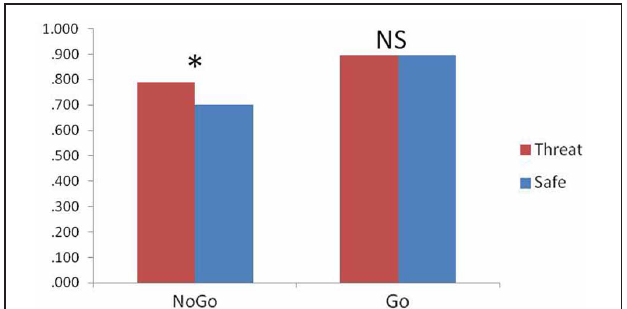
FIGURE 1 | Response Accuracy; threat of shock significantly improved no-go accuracy ( ∗ p < 0 . 05), while having no effect upon go accuracy (NS = not significant), error bars represent standard error of the